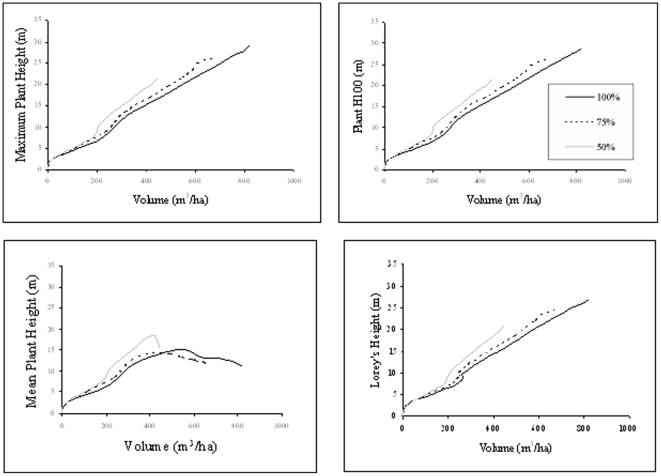

Abies Alba stands of planting density 10000 ha−1 exposed to variations in light intensity (100%, 75%, 50%).Data shown clockwise for Hmax, H100, HLorey and Hmean.